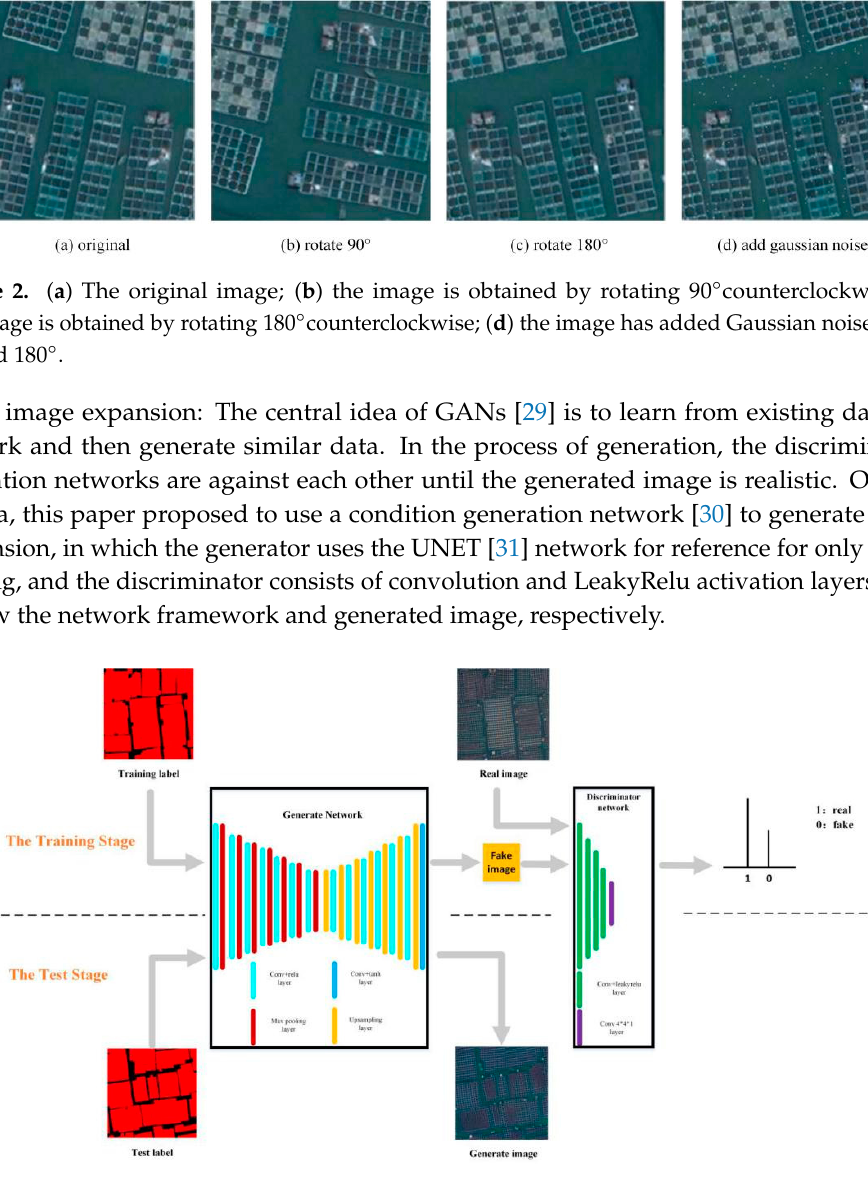
Figure 3. Condition GAN data extension process. The whole process is divided into two stages. The upper half of the dotted line is the training phase. Train and save the model. The lower half of the dotted line is the test phase, generating a new image.